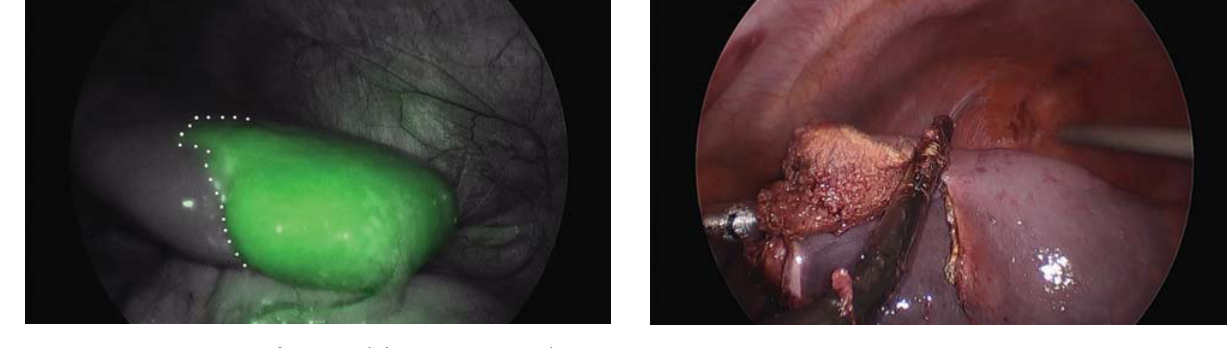
Fig.3 Intraoperative imageafter arterial clamping. Image under near infrared light. To the right of the dotted line, inferolateral pole of the spleen. It shows fl uorescence since arterial vascularization in this portion ispreserved. Tothe leftof the dotted line, supero-medial pole. It does not show fl uorescence as the superior splenic artery, which supplies arterial irrigation to this portion, has been clamped.